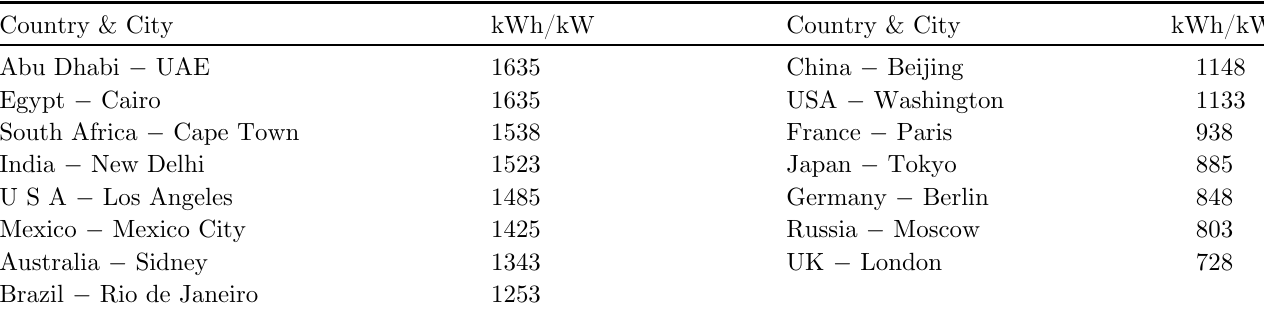
Table 5. Generating electricity per installed PV (kW) in some locations. Country &